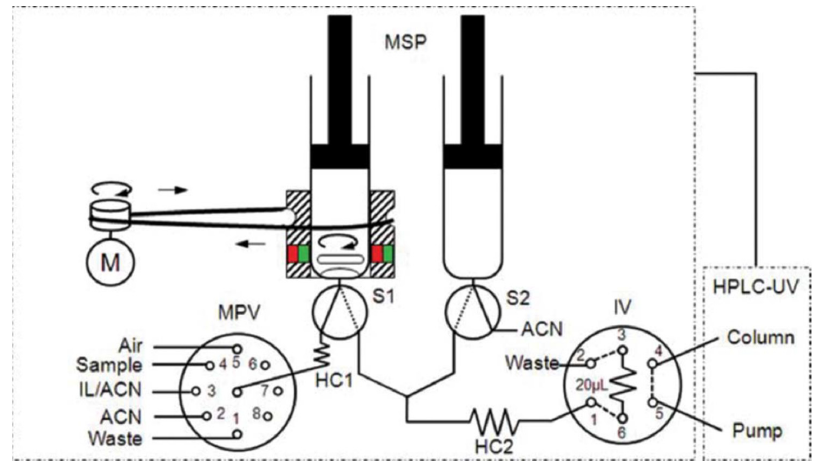
Figure 11. Schematic manifold of the in-syringe magnetic stirring-assisted dispersive liquid–liquid microextraction system coupled to HPLC (in-syringe MSA–DLLME–HPLC) for UV filters determi- nation using UV detection. The manifold was composed of a multisyringe pump (MSP) with two syringes (S1 and S2) with a magnetic stirring system on S1, a multiposition valve (MPV), a high injection valve (IV), a DC motor (M) and an HPLC system [47].